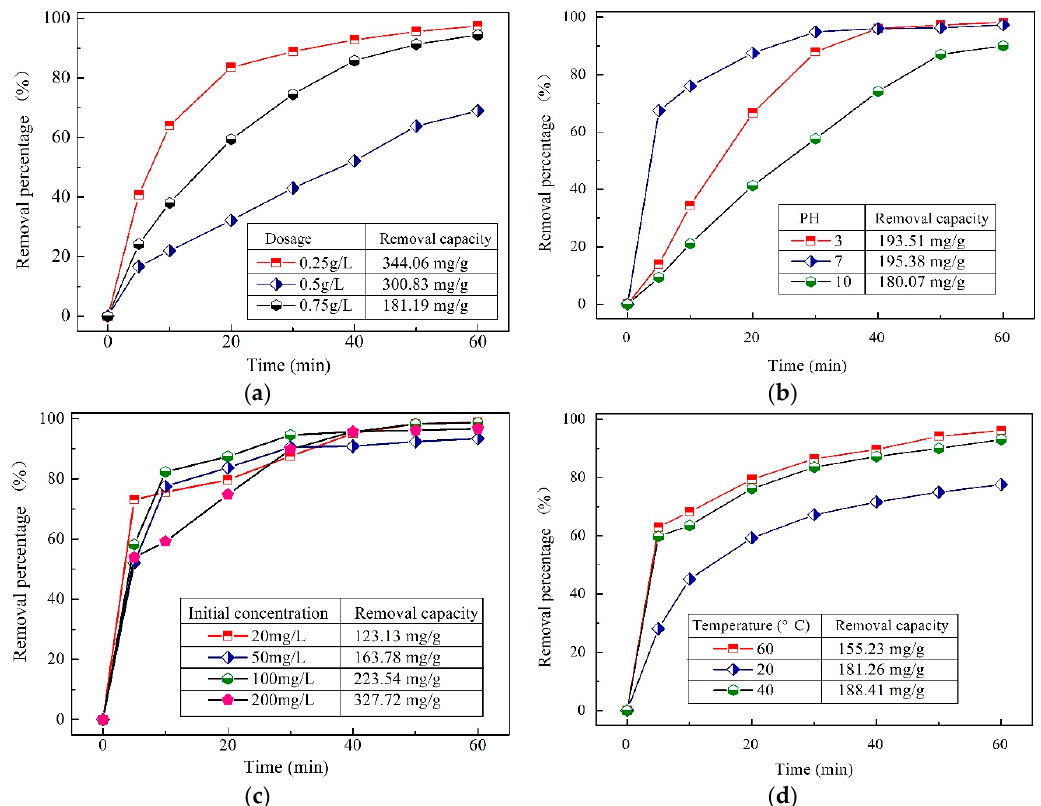
Figure 7. ( a ) Effect of dosage on degradation of MO, with an initial MO concentration of 200 mg/L, temperature of 25 °C, and original pH; ( b ) Effect of the pH values on degradation of MO, in the context of 0.5 g/L BC-nZVI with an initial MO concentration of 50 mg/L; ( c ) Effect of initial concentration on degradation of MO, at the original pH using 0.5 g/L BC-nZVI; ( d ) Effect of temperature on degradation of MO, in the context of 0.5 g/L BC-nZVI with an initial MO concentration of 50 mg/L, temperature of 25 °C, and the original pH.